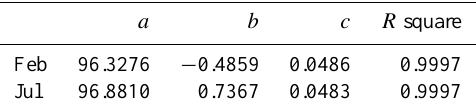
Table 6. Parameters of the exponential fit for the regional- and monthly-average PM 2 . 5 mass concentration thresholds of haze oc- currence in Beijing.